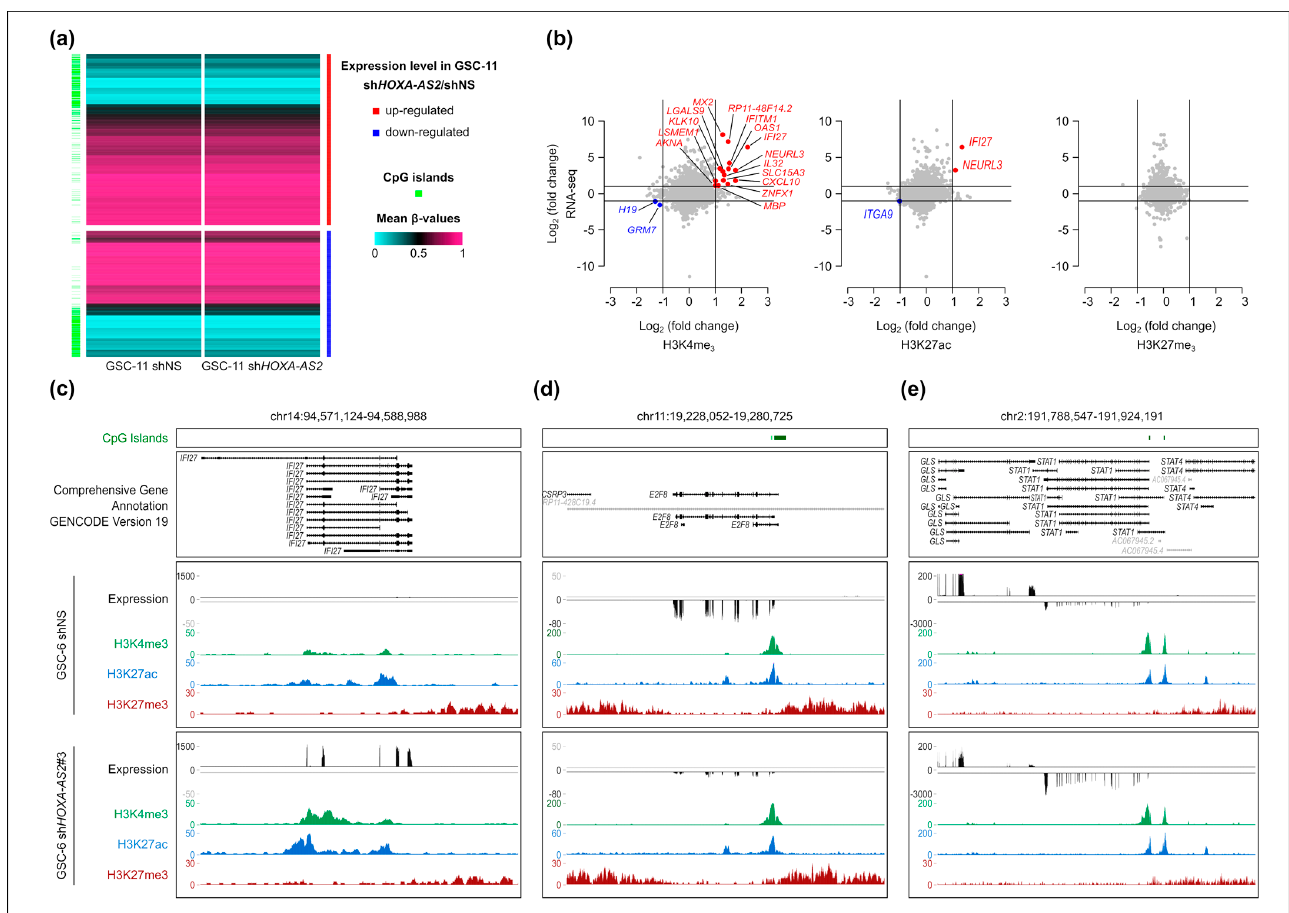
Figure 6. DNA methylation and histone mark changes at deregulated genes following HOXA-AS2 knockdown. ( a ) Promoter DNA methylation level (mean β -values) at the 784 genes deregulated (457 up- and 327 downregulated) following HOXA-AS2 knockdown assessed in control GSC-11 cells (shNS) ( n = 2) and in silenced cells (Sh-HOXA-AS2) ( n = 4). ( b ) Integrative analysis of changes in gene expression (Log2 FC) and in histone mark enrichment following HOXA-AS2 silencing in GSC-6 cells. Genes with significant changes in gene expression and histone mark profile (Log2 FC > 1 or < − 1; FDR < 0.05) are shown in red (upregulated) and blue (downregulated). ( c – e ) Genome Browser view at the IFI27 ( c ), E2F8 ( d ), and STAT1 ( e ) loci to show H3K4me3, H3K27ac, and H3K27me3